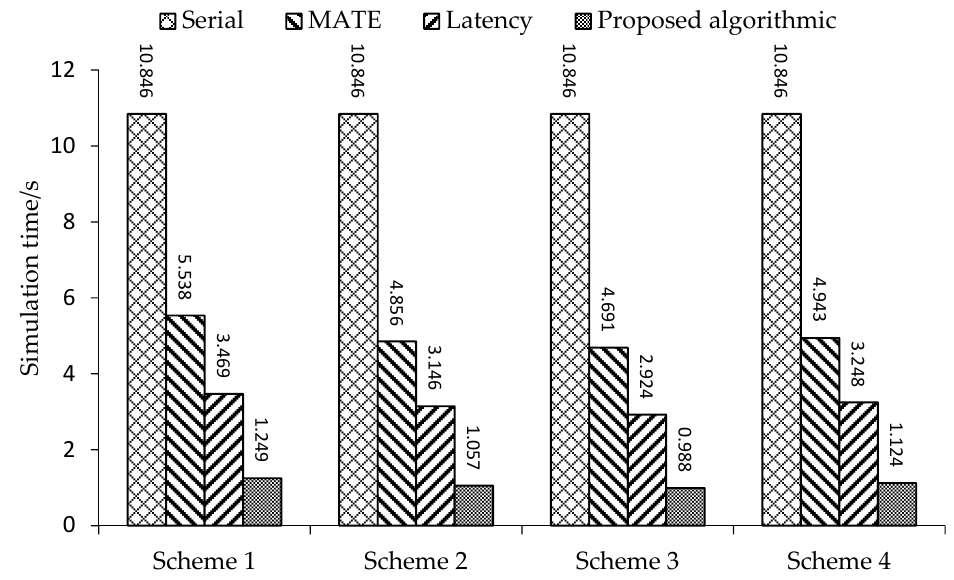
Figure 8. Simulation time of different methods under different partition schemes.